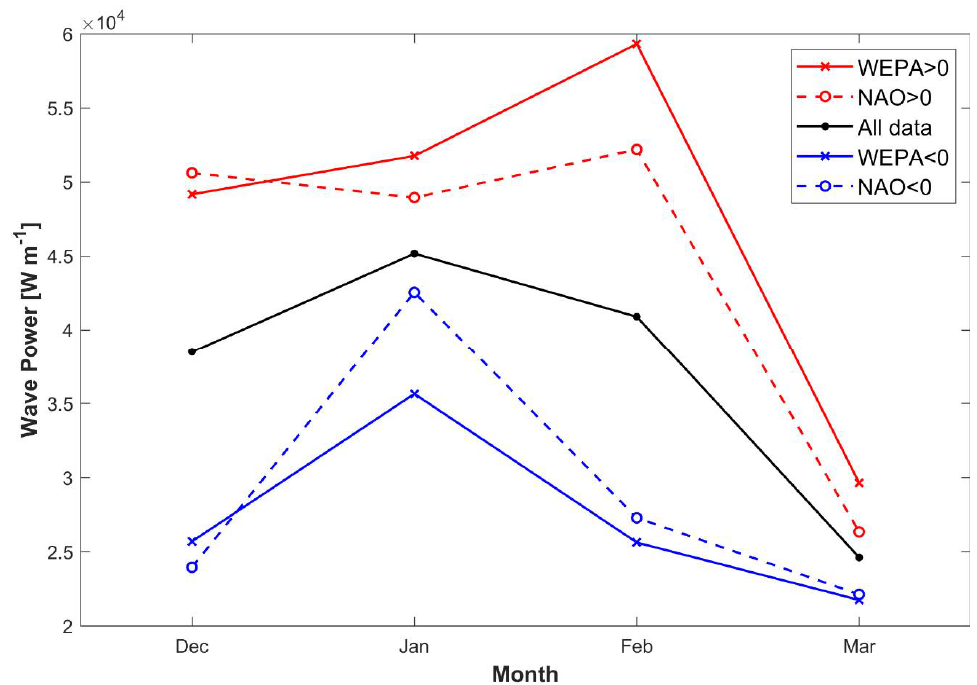
Figure 4. Monthly mean wave power statistics at Perranporth during winter, with both NAO+/WEPA+ and NAO−/WEPA− months considered.